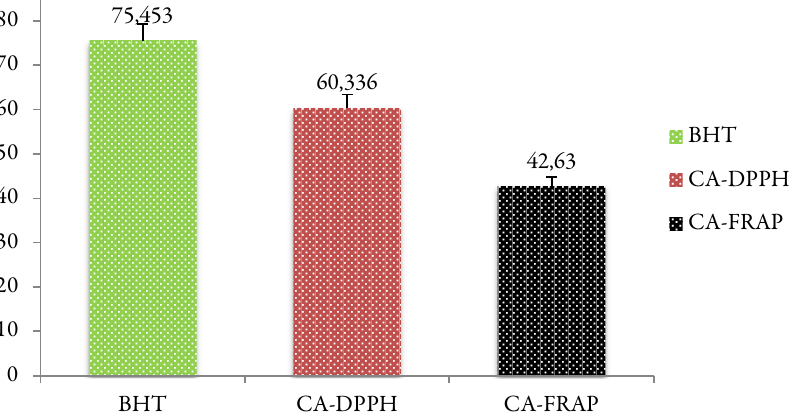
FigureFigureFigureFigure 1111. In vitro antioxidant activity at DPPH and FRAP of the DCM/MeOH extract of C. adansonii Effects of DCM/MeOH extract of C. adansonii bark on sucrose preference and immobility time in the